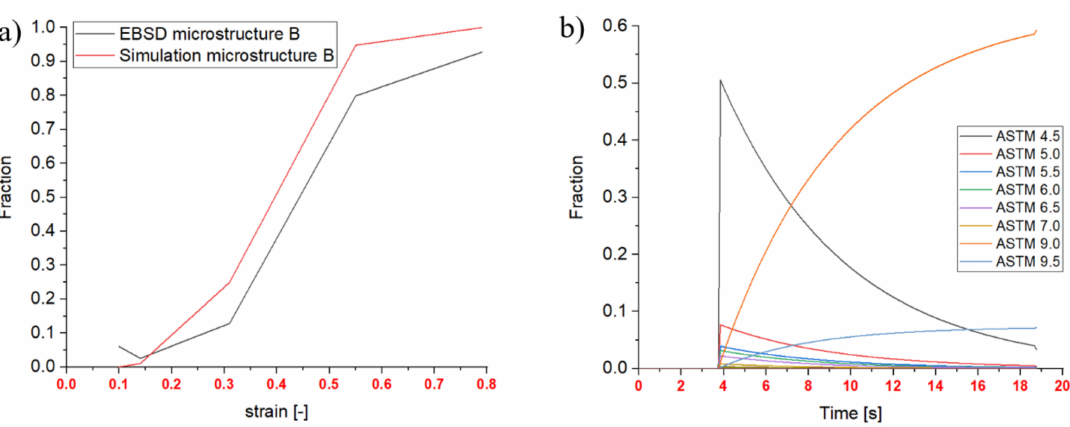
Figure 12. meta-dynamic recrystallization microstructure A: ( a ) Recrystallized fraction over strain, 0.1 s − 1 ; ( b ) MDRX classes 980 ◦ C, 0.1 s − 1 , strain: